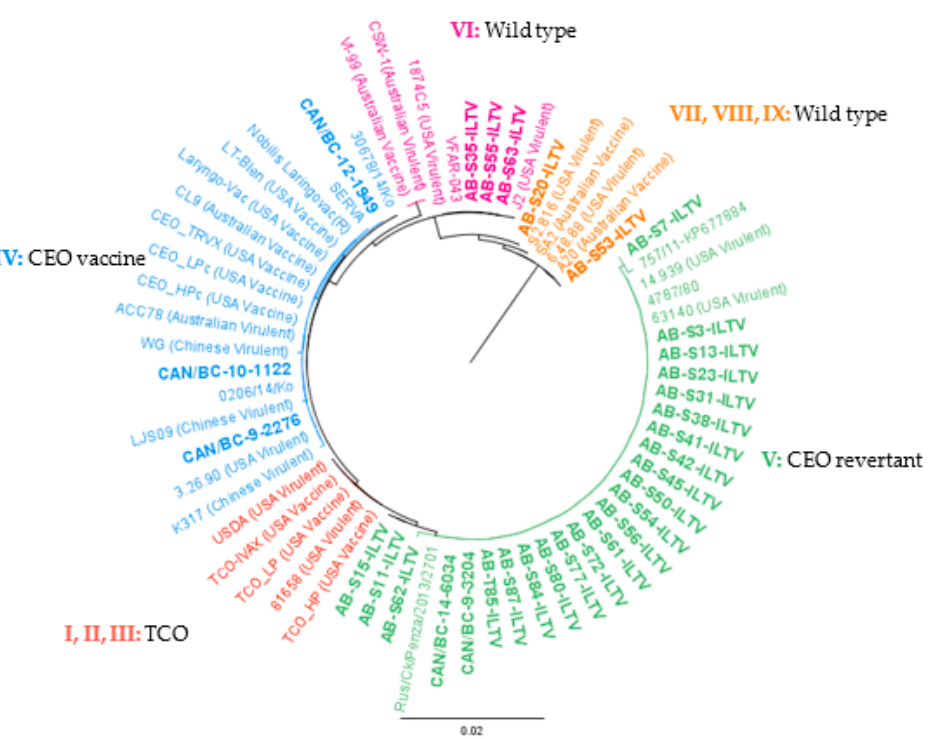
Figure 4. PHYML phylogenetic tree with nucleotide sequences of 66 partial ORF a and b of ILTV. The cladogram includes 34 ILTV reference strains downloaded from the GenBank and 32 ILTV Canadian strains characterized in the current study in bold (AB = 27, BC = 5). The genotype nomenclature used is based on [34]. Geneious version 10.0 was created by Biomatters. Available from http://www.geneious.com.